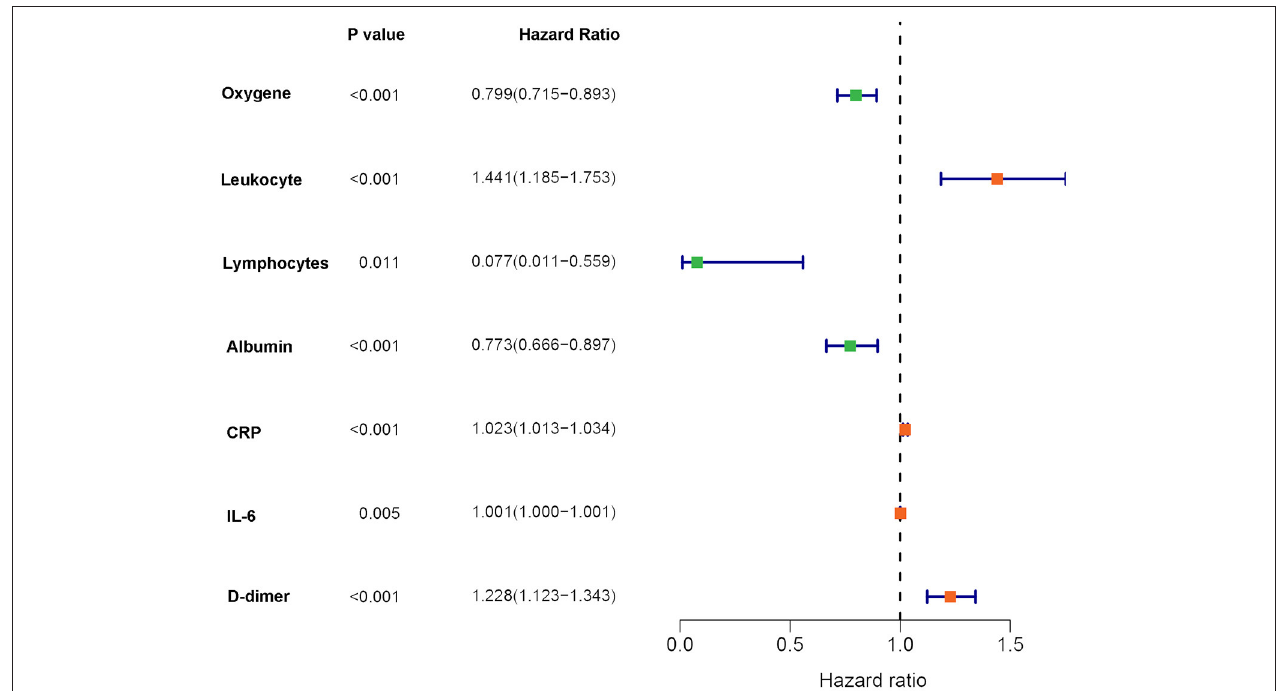
FIGURE 4 | Forest plot for the univariate Cox regression analysis results in the training dataset.